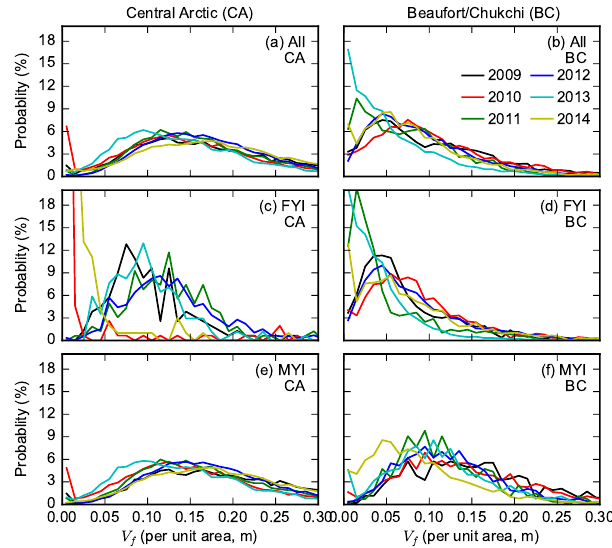
Figure 9. Probability distributions of the surface feature volume (per unit area), V f , (using a 20cm elevation threshold) within the (a) Central Arctic and (b) Beaufort/Chukchi regions (shown in Fig. 8) from 2009 to 2014. The bin width is 1cm. The statistics (mean and mode of each distribution) are summarized in Table